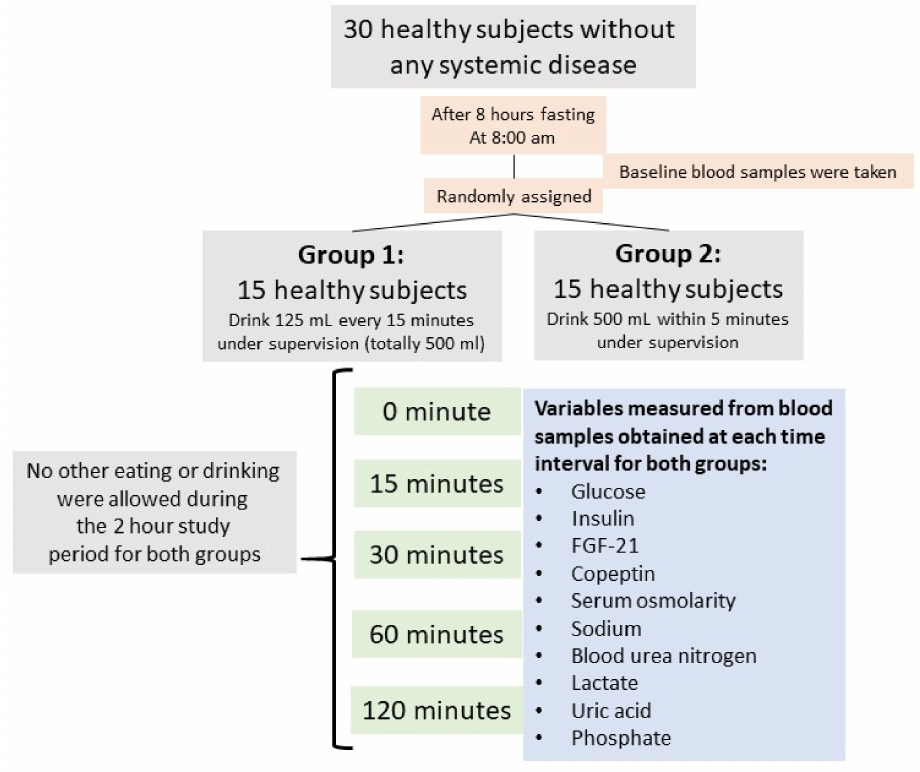
Figure 1. Flow diagram of the study